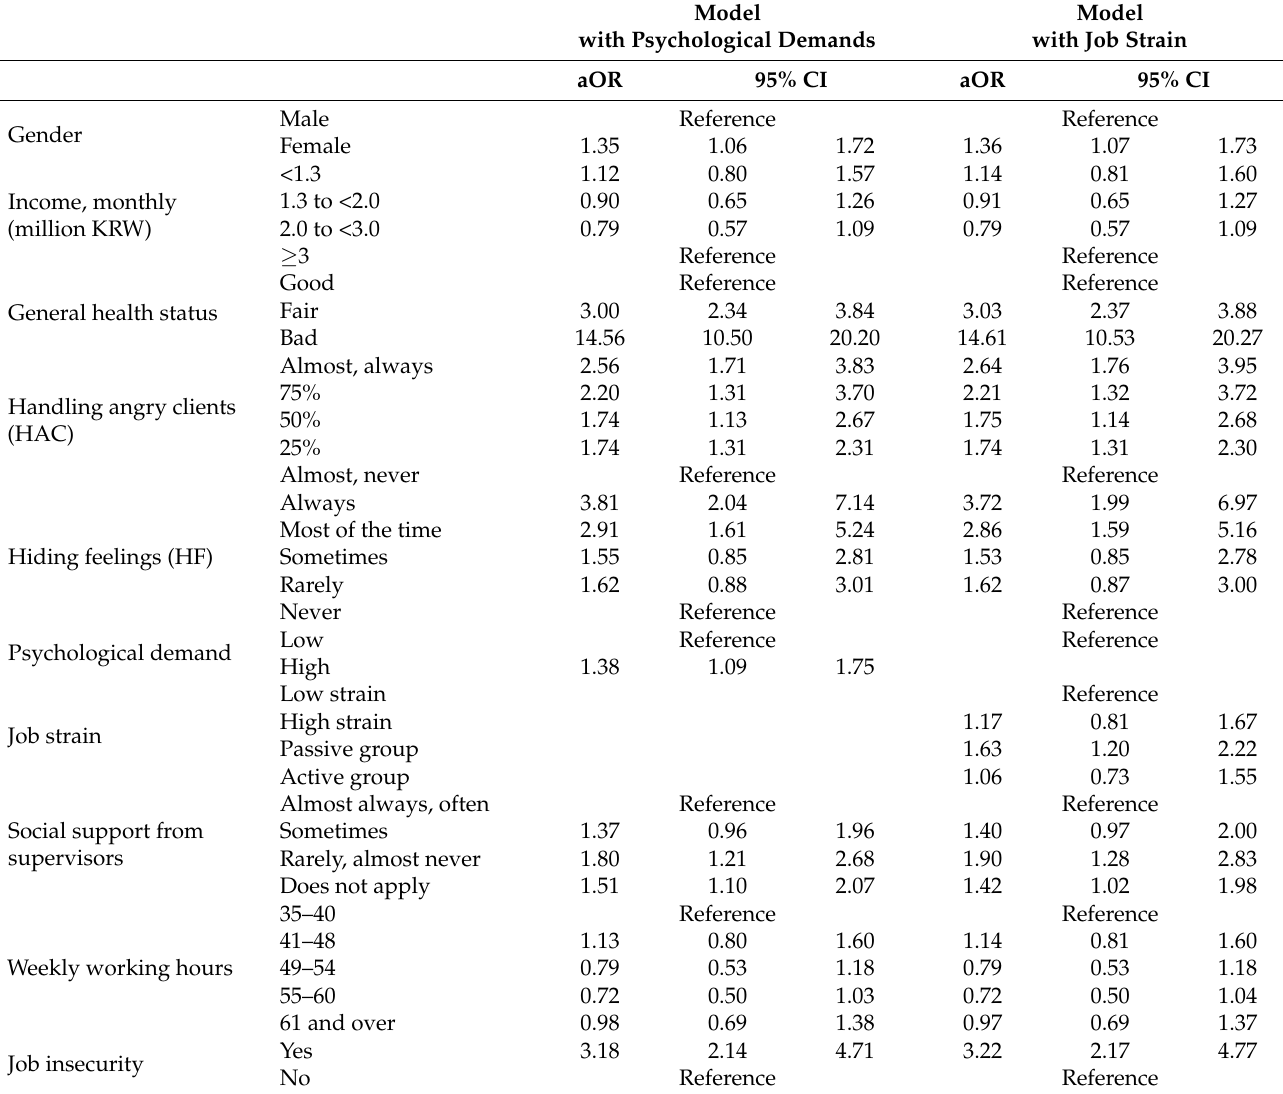
Table 3. Odds ratios for poor mental health, with multivariable logistic regression models including all variables shown in the